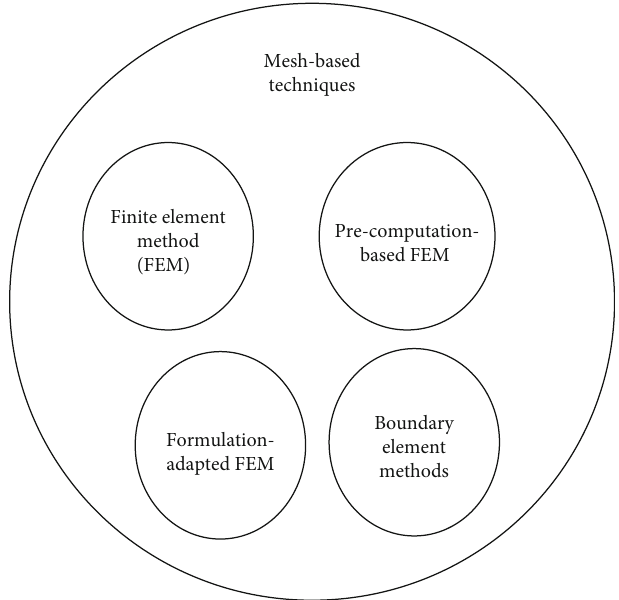
Figure 5: Overview of common computation strategies for mesh-based